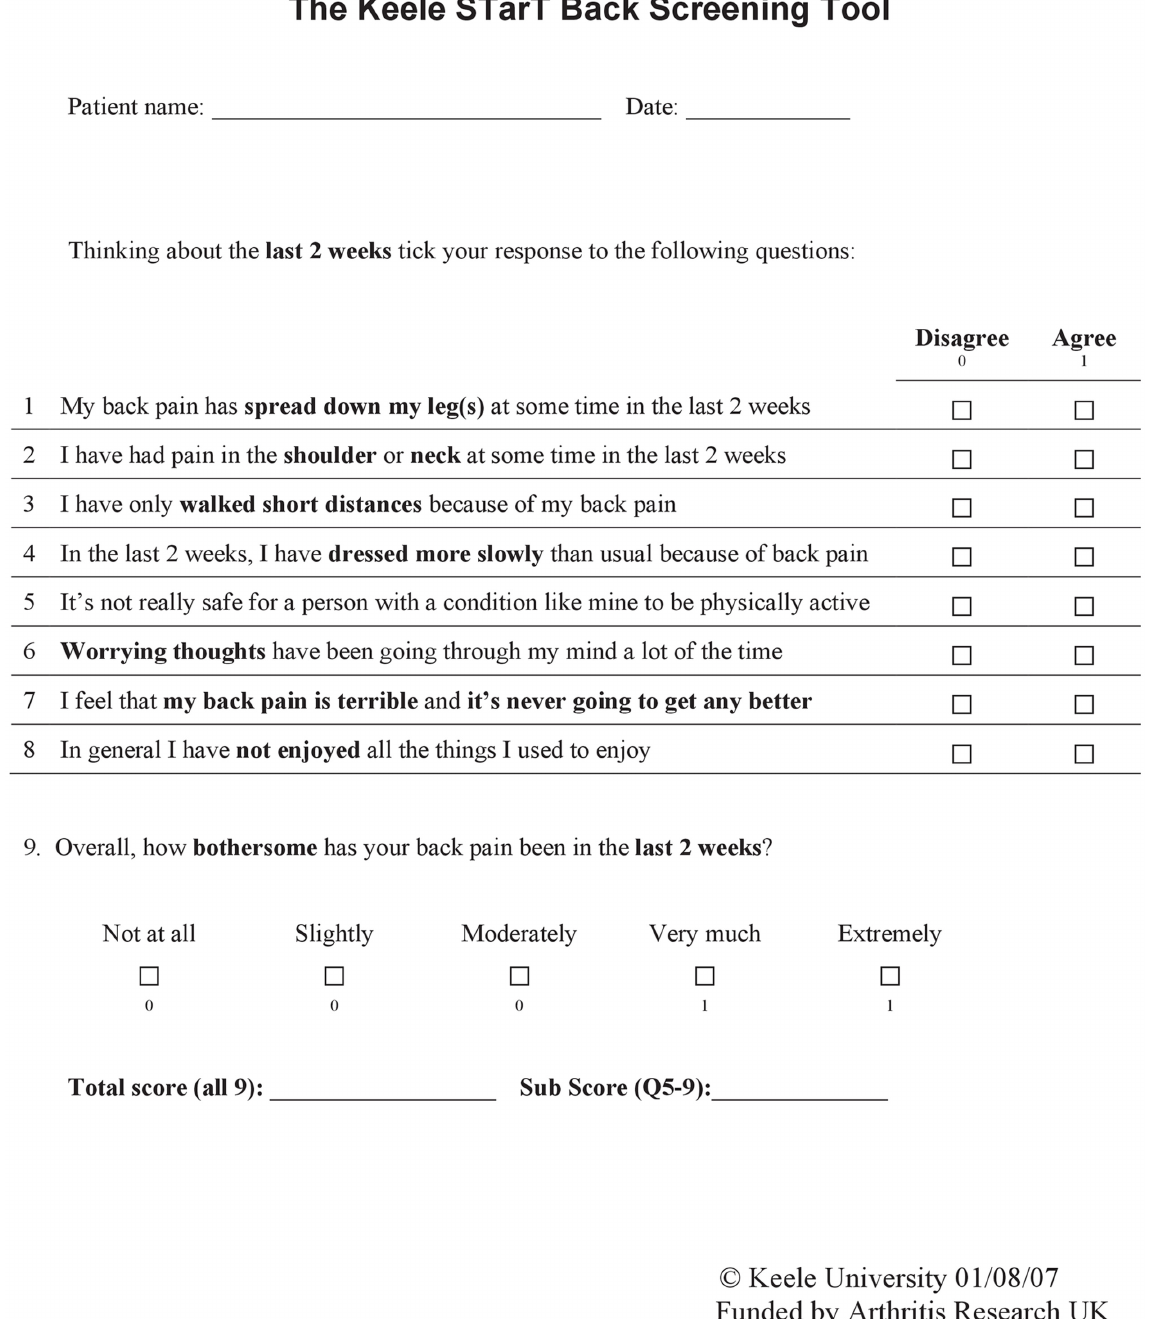
Fig 1. STarT Back Tool. Response options for items 1 – 8 are “ disagree ” (0 points) or “ agree ” (1 point). Responses to item 9 are on a scale of 1 – 5: “ not at all, ” “ slightly, ” “ moderately, ” “ very much, ” or “ extremely. ” The first three options ( “ not at all, ” “ slightly, ” and “ moderately ” ) are scored as 0, and the remaining two options ( “ very much ” and “ extremely ” ) are scored as 1. Items 1 – 4 constitute the physical subscale. Items 5 – 9 constitute the psychosocial subscale.